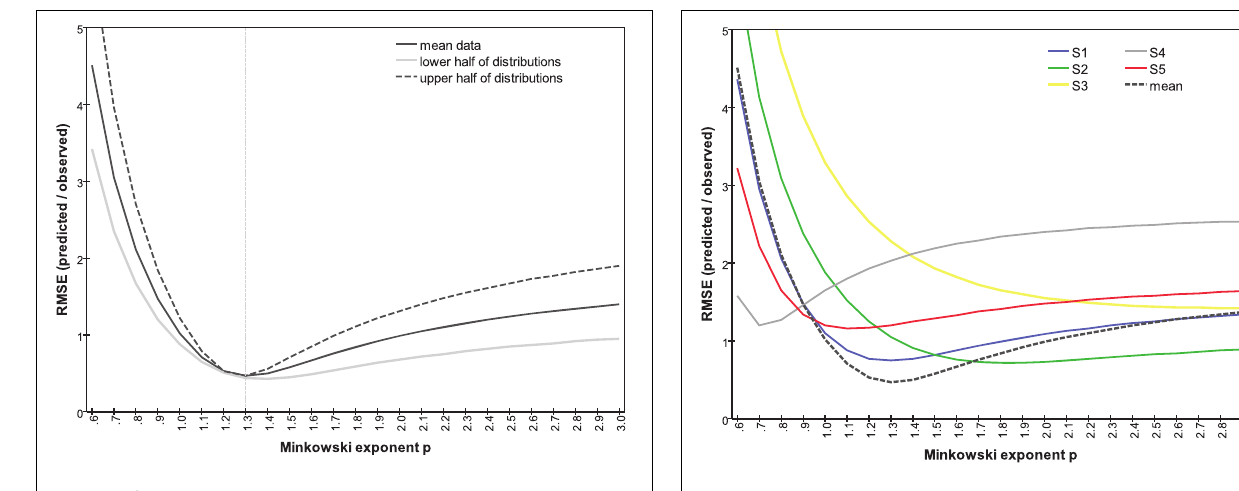
FIGURE 10 | RMSE between predicted and observed dissimilarities as a function of Minkowski exponent p , calculated separately for each subject’s